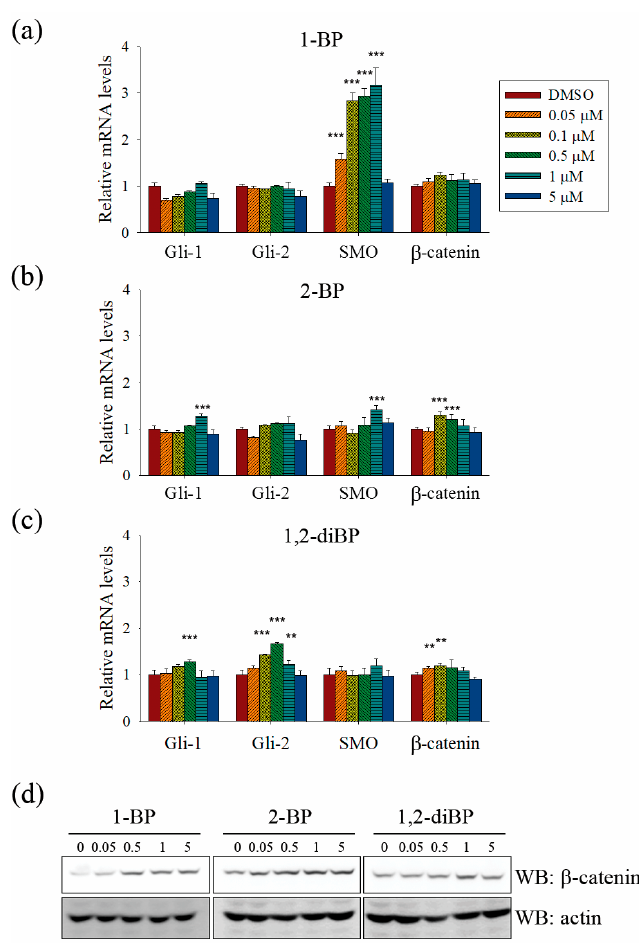
Figure 6. The effects of BP compounds on the expression of transcription factors related to the Hedgehog, Notch, and Wnt signaling pathways. CSC221 cells were treated with various concentrations of 1-BP, 2-BP, or 1,2-diBP for 48 h ( a – c ) or 72 h ( d ). ( a – c ): Total RNA from 1-BP- ( a ), 2-BP- ( b ), or 1,2-diBP-treated cells ( c ) were prepared, cDNA was synthesized, and real-time PCR was performed with the primers listed in Materials and Methods. Data represent the relative mRNA expression levels compared with the untreated control groups for each target gene. Data are shown as the mean ± SEM and were analyzed by one-way ANOVA. * p < 0.05, ** p < 0.01, and *** p < 0.001 vs. the untreated control groups for each target gene. ( d ) Cell lysates were subjected to immunoblot analyses with β -catenin antibody.